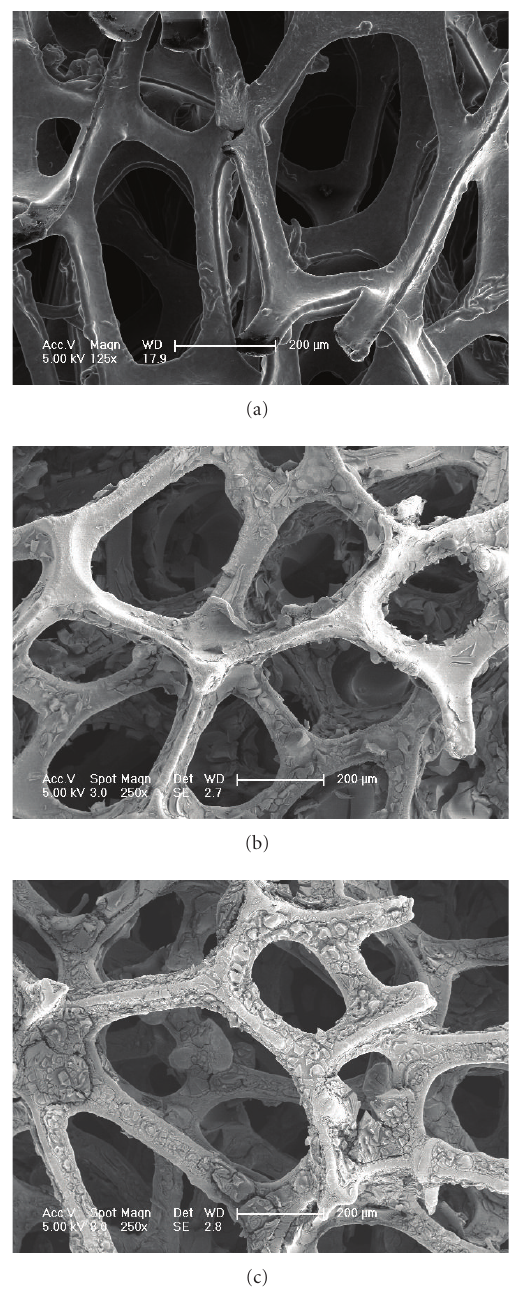
Figure 6: FE-SEM images of bare-foam nickel (a), S2 (b), and S2T2 (c). The scale is 200 μ m.